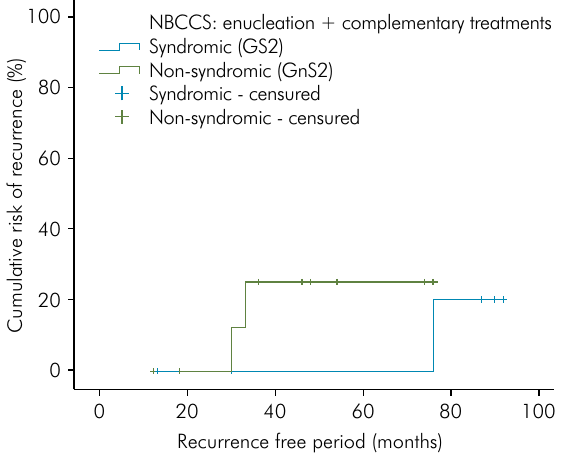
Figure 7. The cumulative risk of recurrence by the Kaplan-Meier analysis according to the association or lack thereof with the nevoid basal cell carcinoma syndrome.